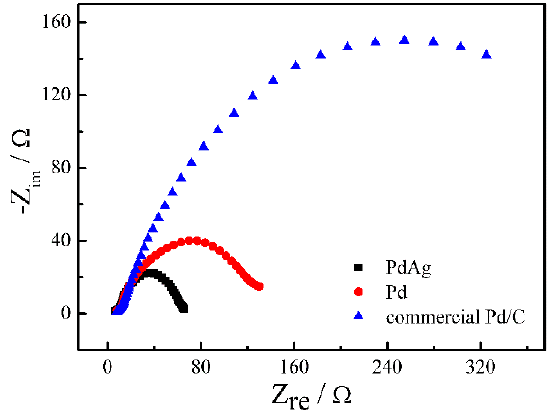
Figure 7. Nyquist plots of PdAg, Pd and commercial Pd/C for ethanol oxidation in 1.0 M C 2 H 5 OH + 1.0 M KOH solution with potential of − 0.3 V.